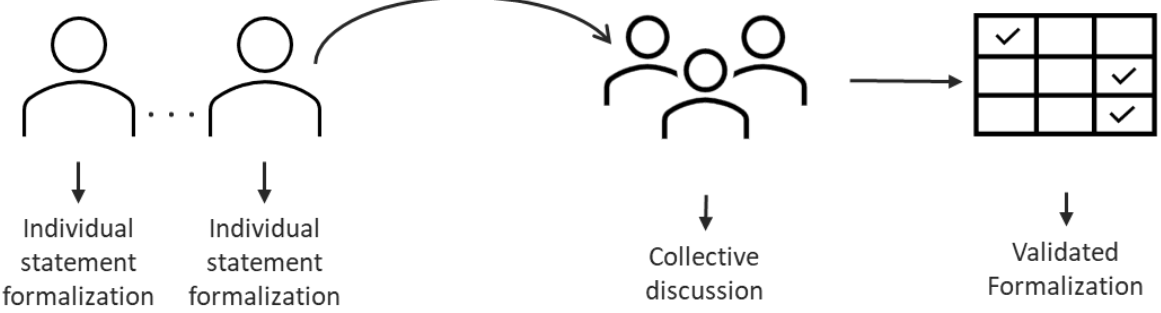
Figure 2. Qualitative analysis for the formalization carried out by the research team.